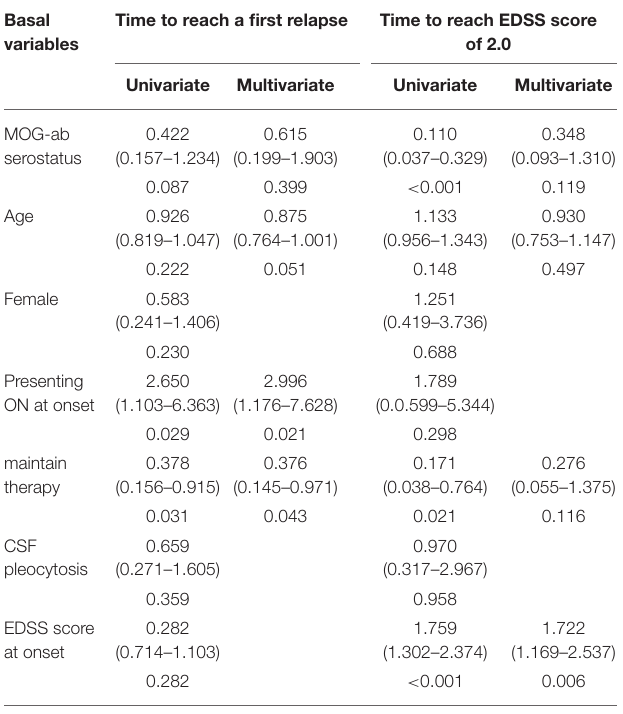
TABLE 5 | Effects of baseline epidemiologic, clinical and CSF characteristics on time to reach a first relapse and time to reach EDSS score of 2.0. Basal Time to reach a first relapse Time to reach EDSS score variables